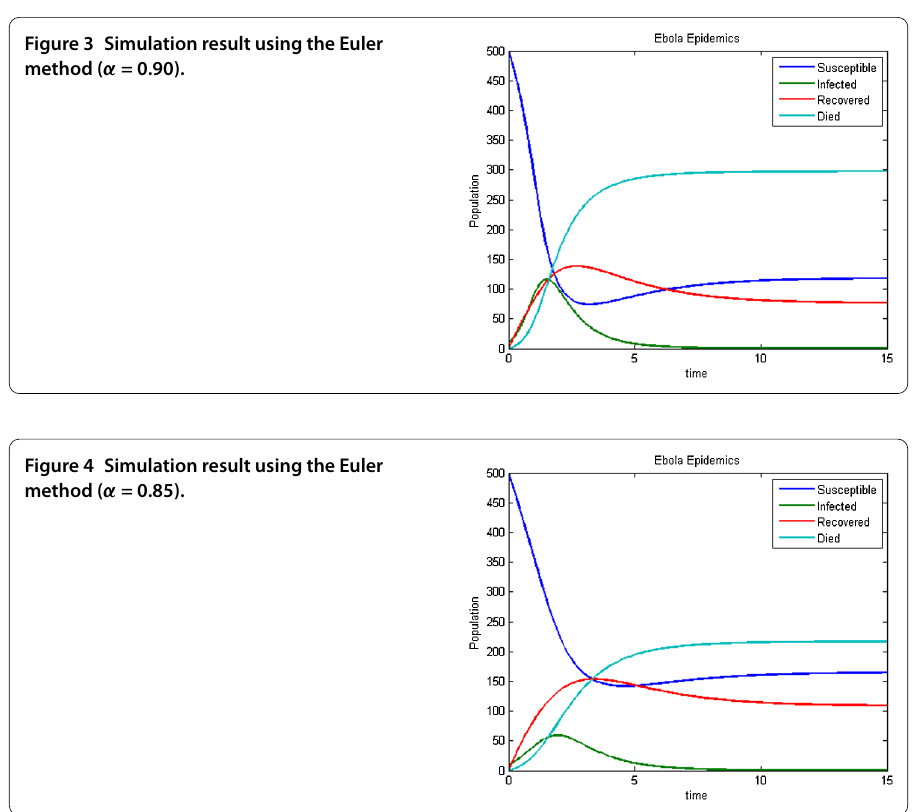
Figure 4 Simulation result using the Euler method ( α =